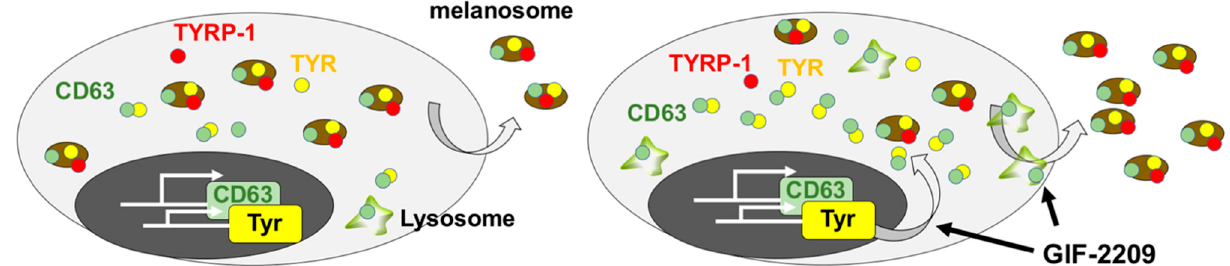
Figure 7 . A hypothetical model of GIF-2209-mediated melanogenesis activation. By interacting with lysosome and autophagy systems, GIF-2209 may enhance secretion of matured melanosomes, leading to a lack of melanosomes with melanogenic enzymes in melanocytes. Thus, a high concentration of GIF-2209 ultimately decreased intracellular melanosomes, accompanied by decreased levels of intracellular melanin and melanogenic enzymes including TYR and TYRP-1. In contrast, a lower concentration of GIF-2209 stimulates TYR expression, supplying TYR protein whose level is a rate-limiting step in melanin synthesis, leading to a high content of intracellular melanin.